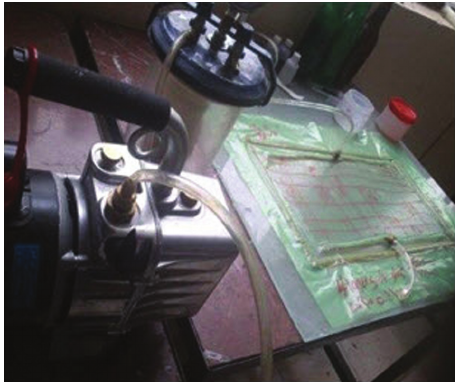
Figure 5 VIP method.